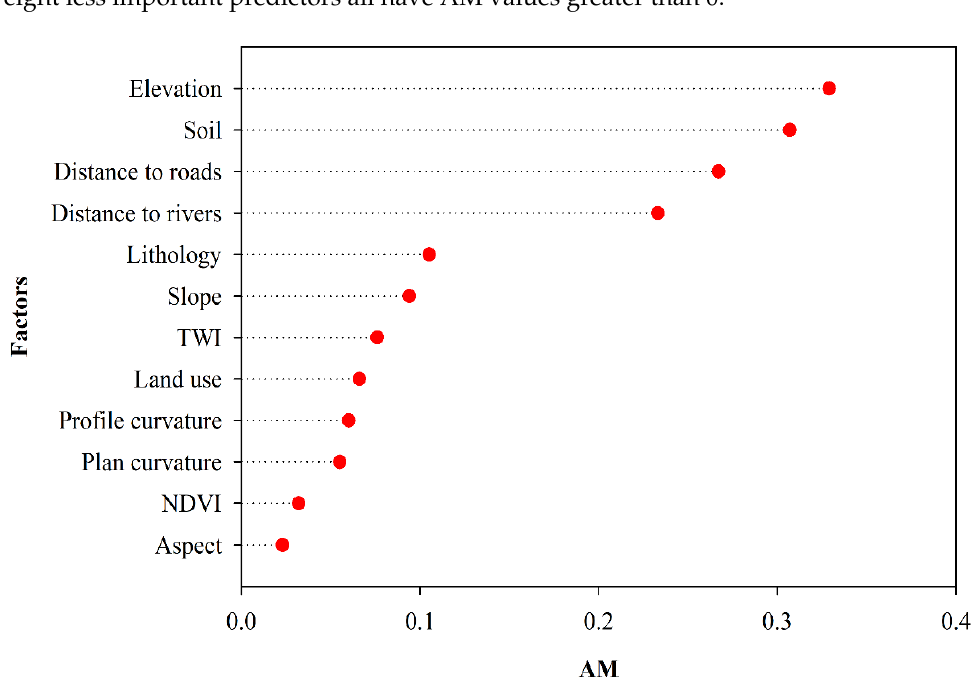
Figure 4. Importance of conditioning factors based on FT